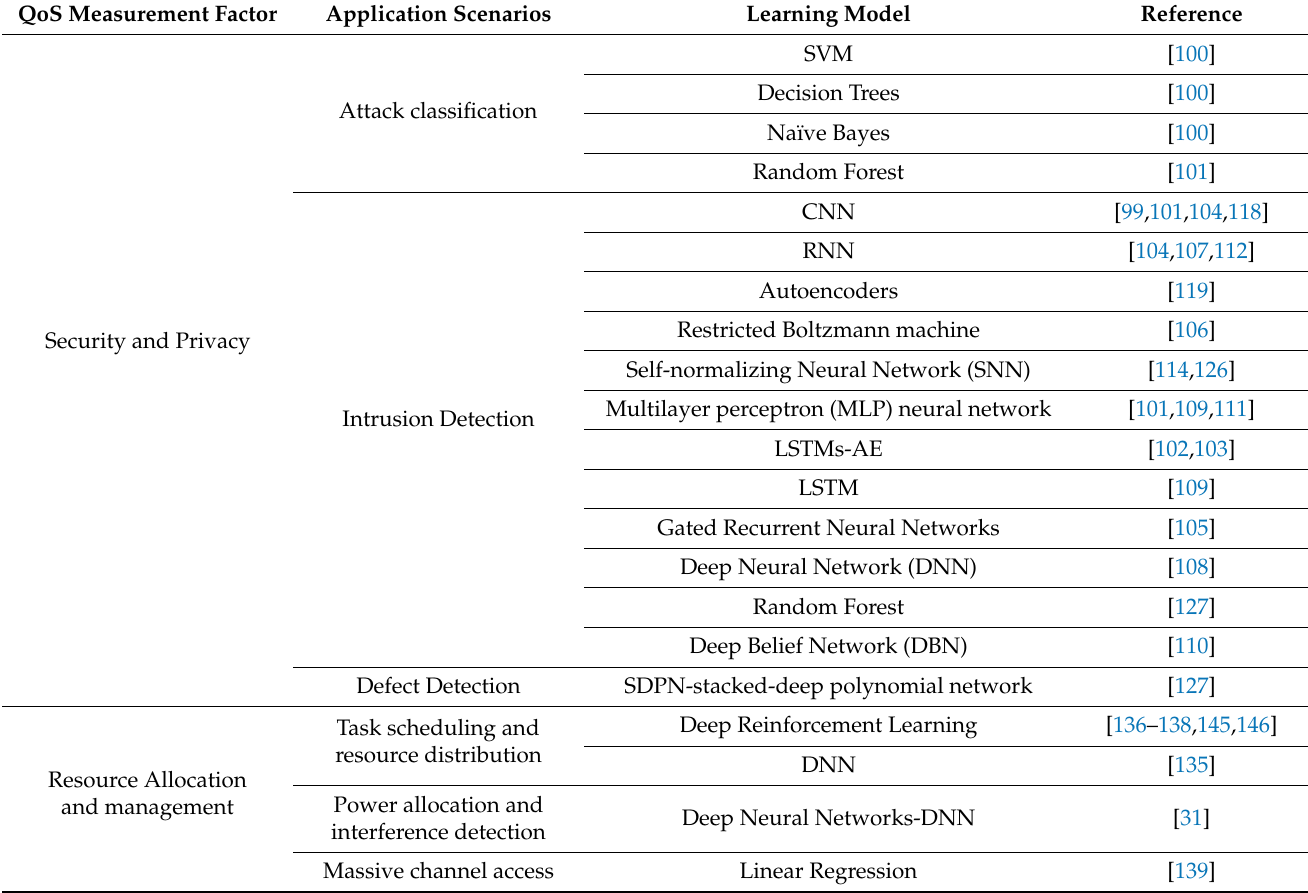
Table 3. Deep Learning application to Security and resource allocation in